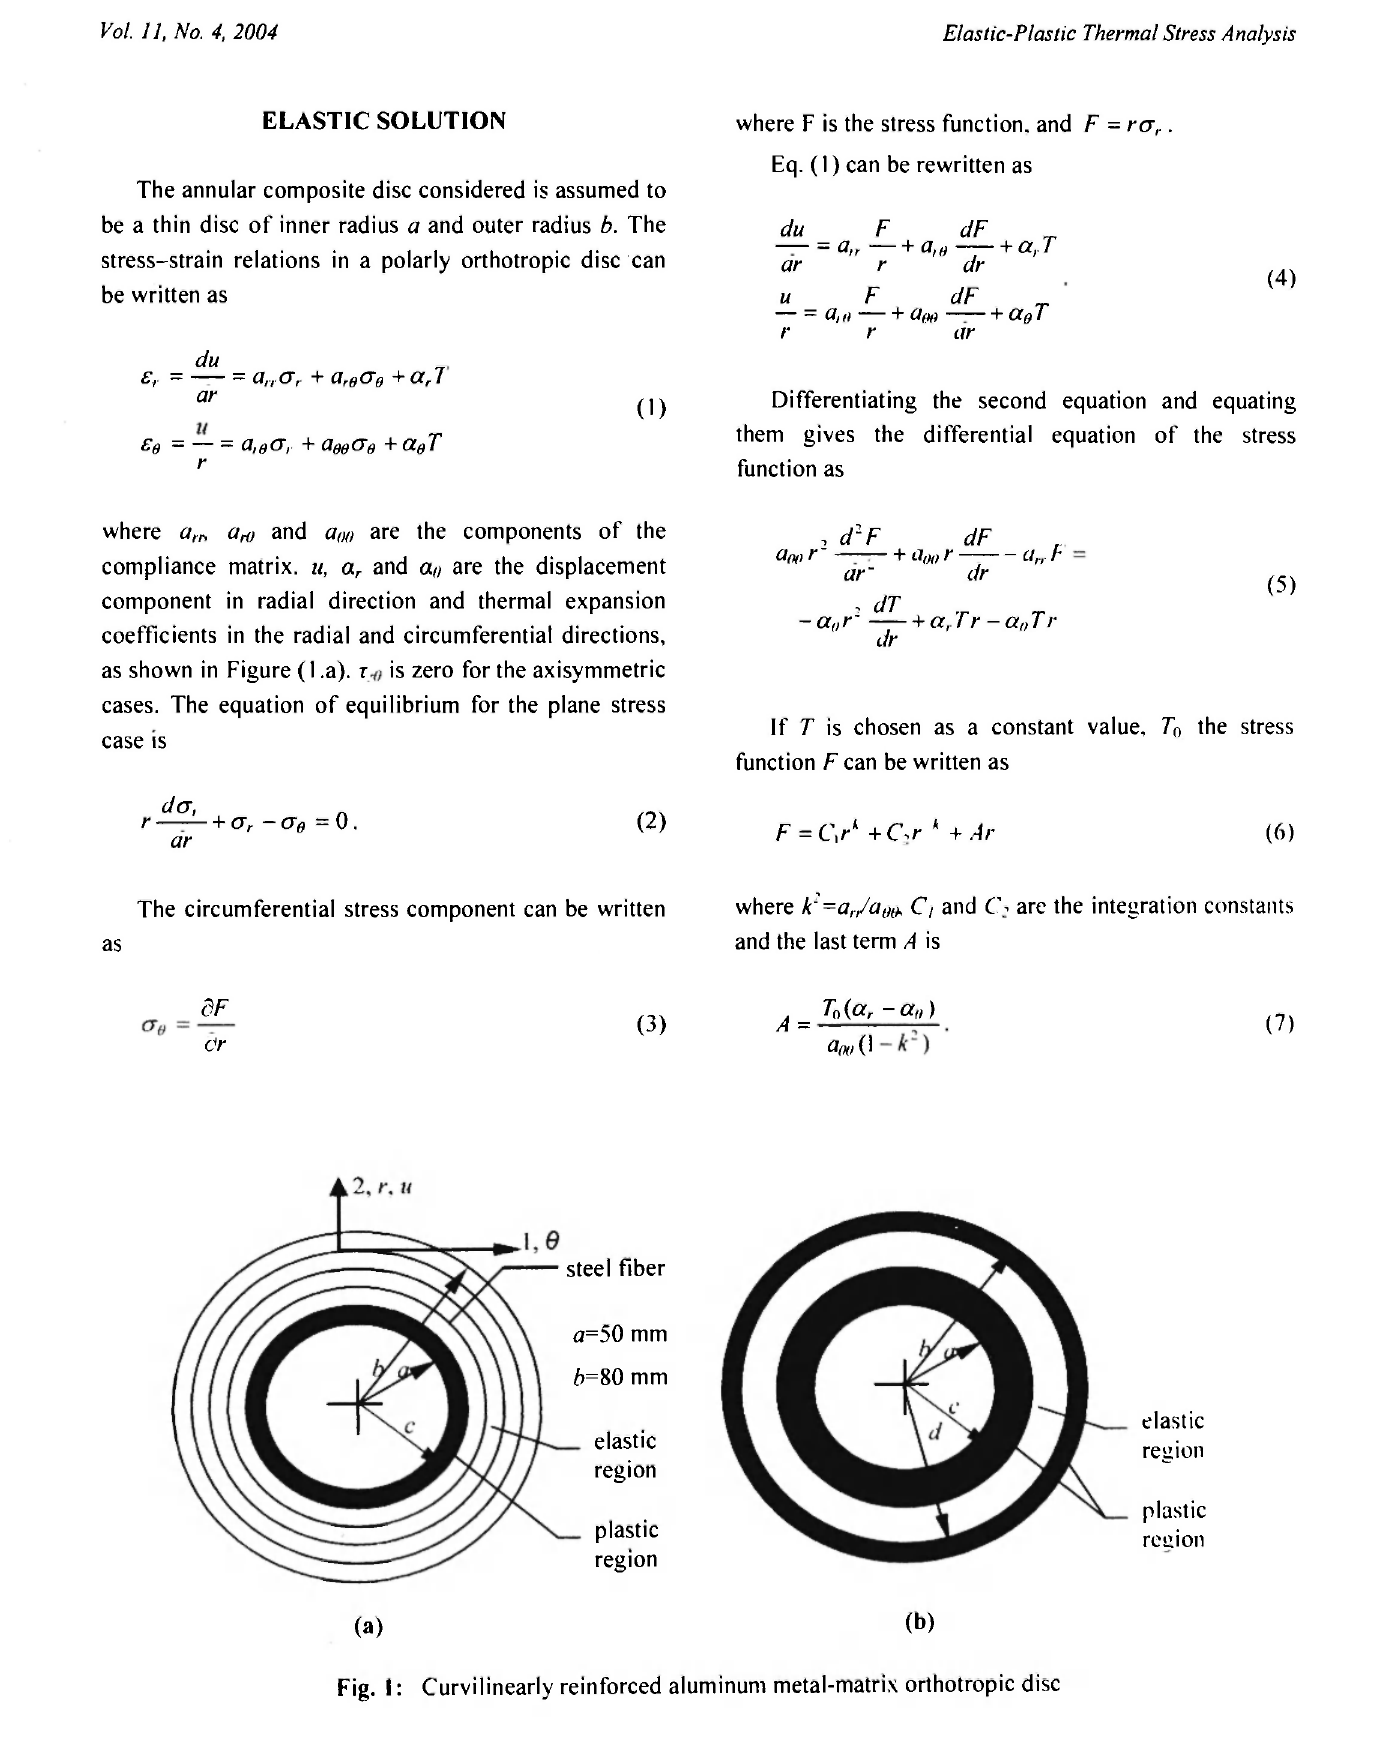
Fig. 1 : Curvilinearly reinforced aluminum metal-matrix orthotropic